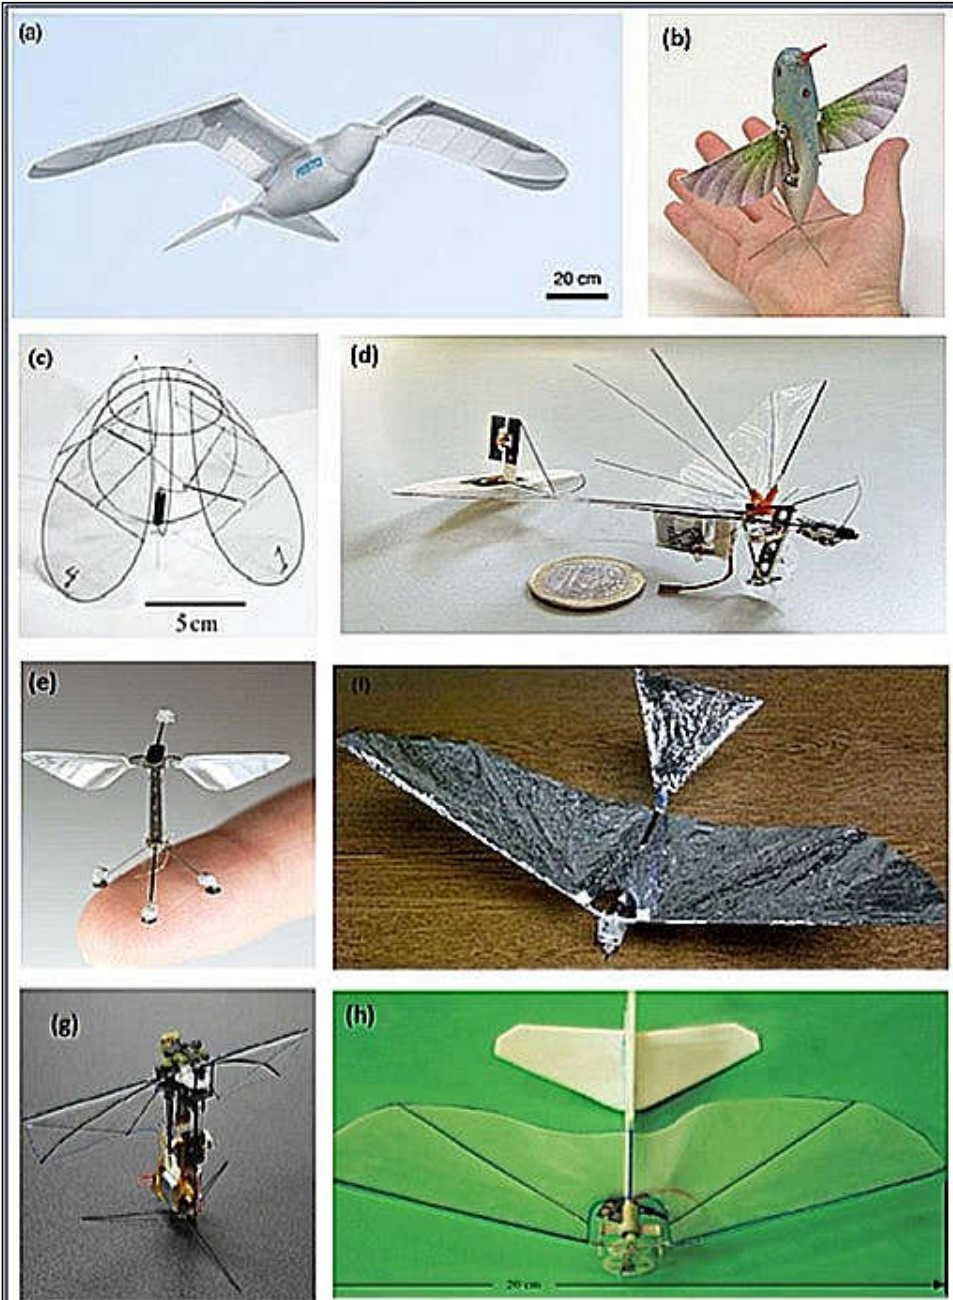
Figure 1. ( a ) Festo-smartbird, manufactured by Festo’s Bionic Learning Network (photo courtesy of Festo [14]); ( b ) AeroVironment Nano Hummingbird (photo courtesy of AeroVironment); ( c ) a four-winged robot that flies with a jellyfish-like motion (photo courtesy of [16]); ( d ) DelFly MAV (photo courtesy of Wikipedia-DelFly); ( e ) insect-scale flying robot (photo courtesy of Wyss Institute Harvard University); ( f ) big bird developed by University of Maryland (Photo courtesy of University of Maryland); ( g ) Beetle Mimicking Flapping MAV (Photo courtesy of [11]); ( h ) Flapping wing developed by Tamkang University (Photo courtesy of [29]).